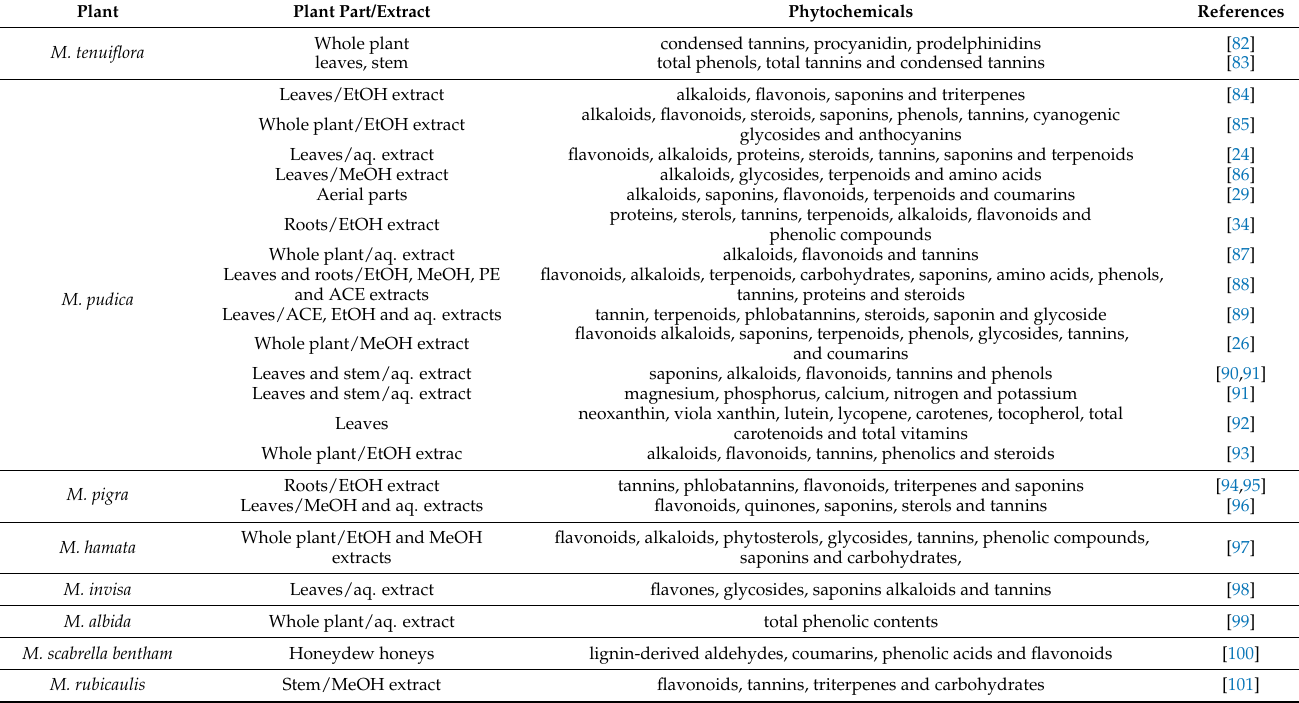
Table 1. Phytochemical screening of different species of genus Mimosa